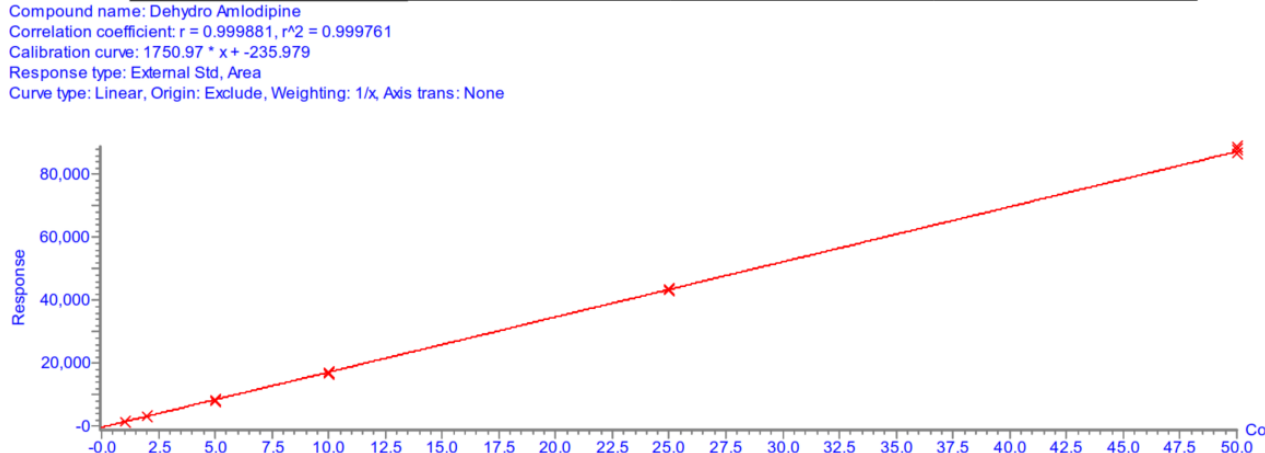
Figure A8. DAML calibration curve in human plasma, concentration range 1 − 50 ng/mL, day 1.